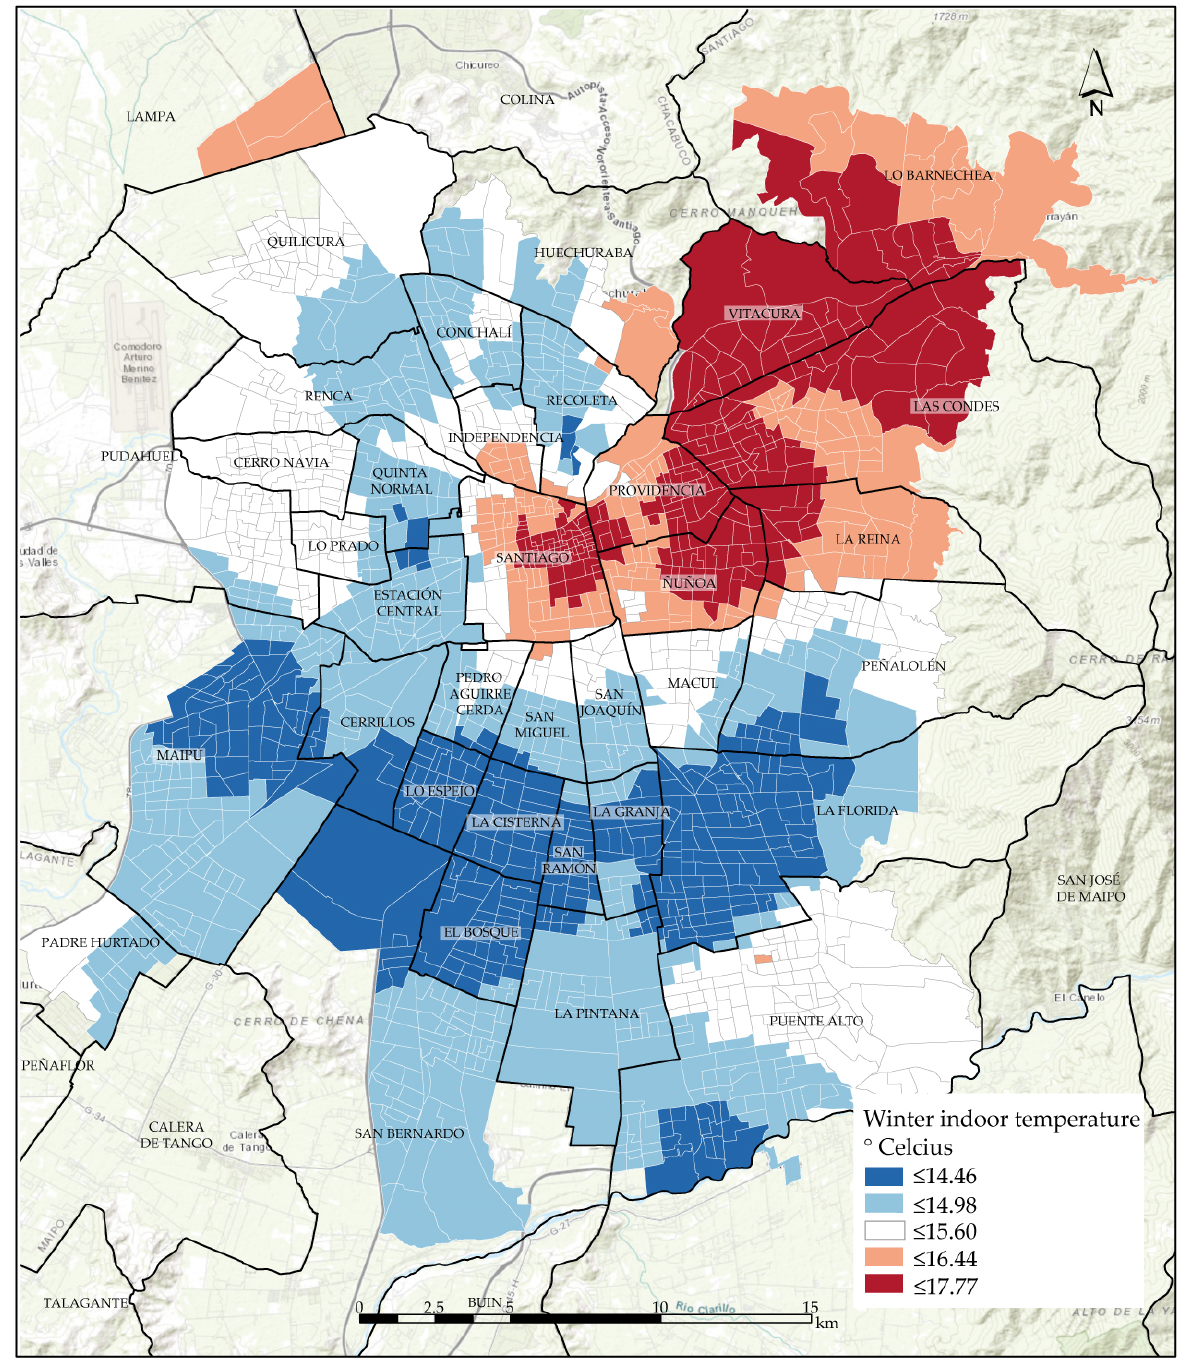
Figure 3. Distribution of the inside temperature of the homes in winter as a dependent variable.